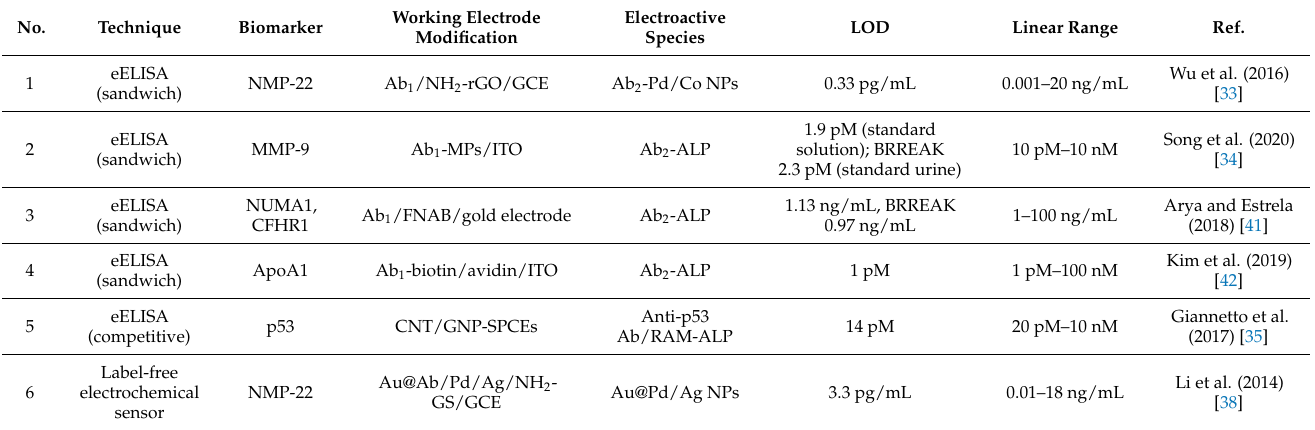
Table 2. Summary of the amperometric sensor reported for bladder cancer urine biomarker